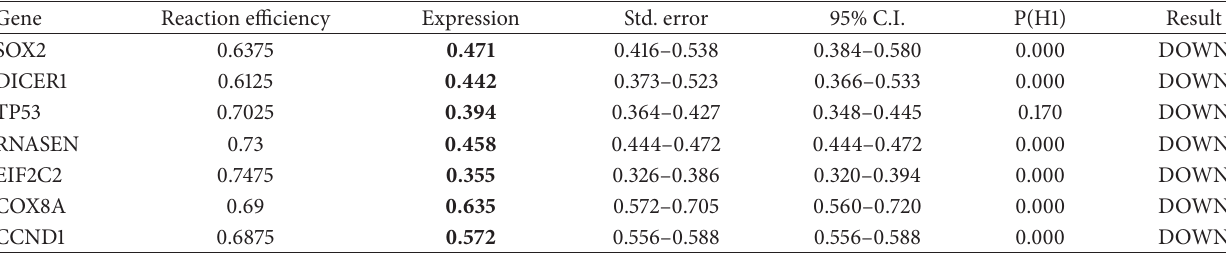
Table 6: Example of REST analysis on SOX2 and SOX2 ceRNAs levels of transcription quantified by RT-PCR compared to controls and normalized against 𝛽 -actin expression in SW1736 ATC cell line after SOX2 silencing. P(H1) is the probability of the alternative hypothesis that the difference between sample and control groups is due only to